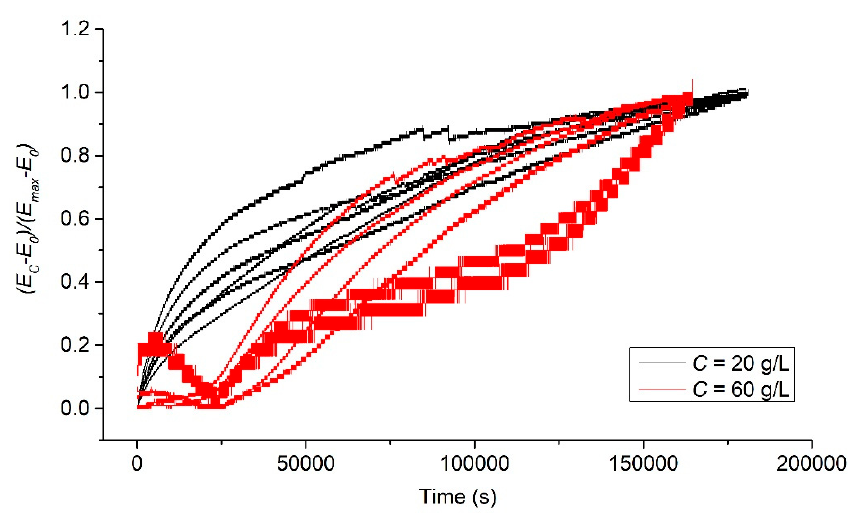
Figure 16. Molecular diffusion curves of different concentration gradients.